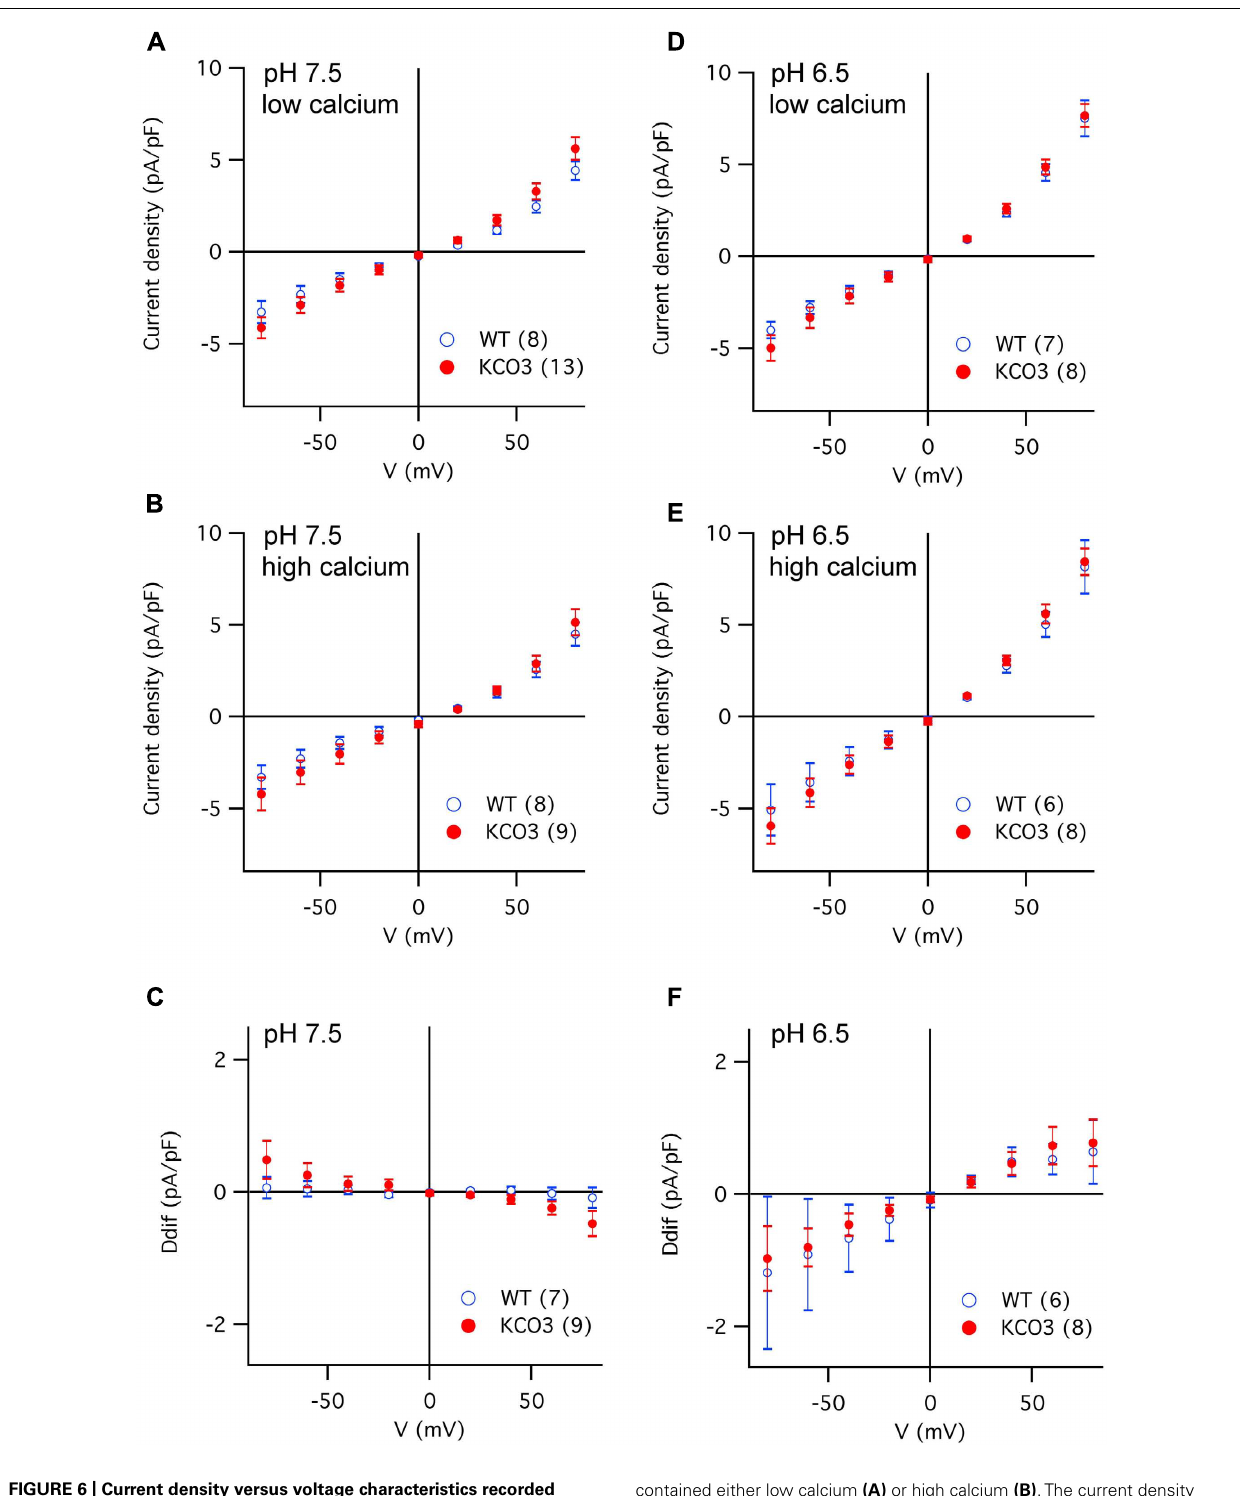
contained either low calcium (A) or high calcium (B) .The current density difference (Ddif) between high and low calcium conditions was calculated for individual vacuoles and averaged (C) . (D,F) As in (A–C) , but in bath solutions of pH 6.5, in low calcium (D) , in high calcium (E) , difference ( F ; Ddif). In each panel, the number ofWT or KCO3 vacuoles analyzed is given in